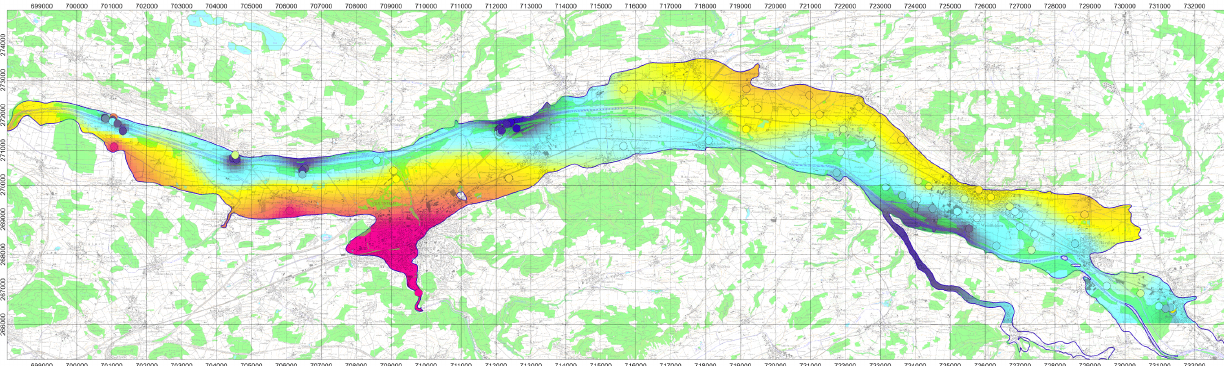
! Fig. 2. Plan view representation of alkalinity in the groundwater of River Thur valley, using CHEMMAP. Yellow, orange, and red hues, high alkalinity ( > 350mgL − 1 ; 61mgHCO − L − 1 =1mmolL − 1 ), light and dark blue hues, low alkalinity ( < 350mgL − 1 ). 3 1mmolL − 1 =61mgL − 1 . Colored domain: Alluvial groundwater, thickness > 2m. North is up; General groundwater flow direction from